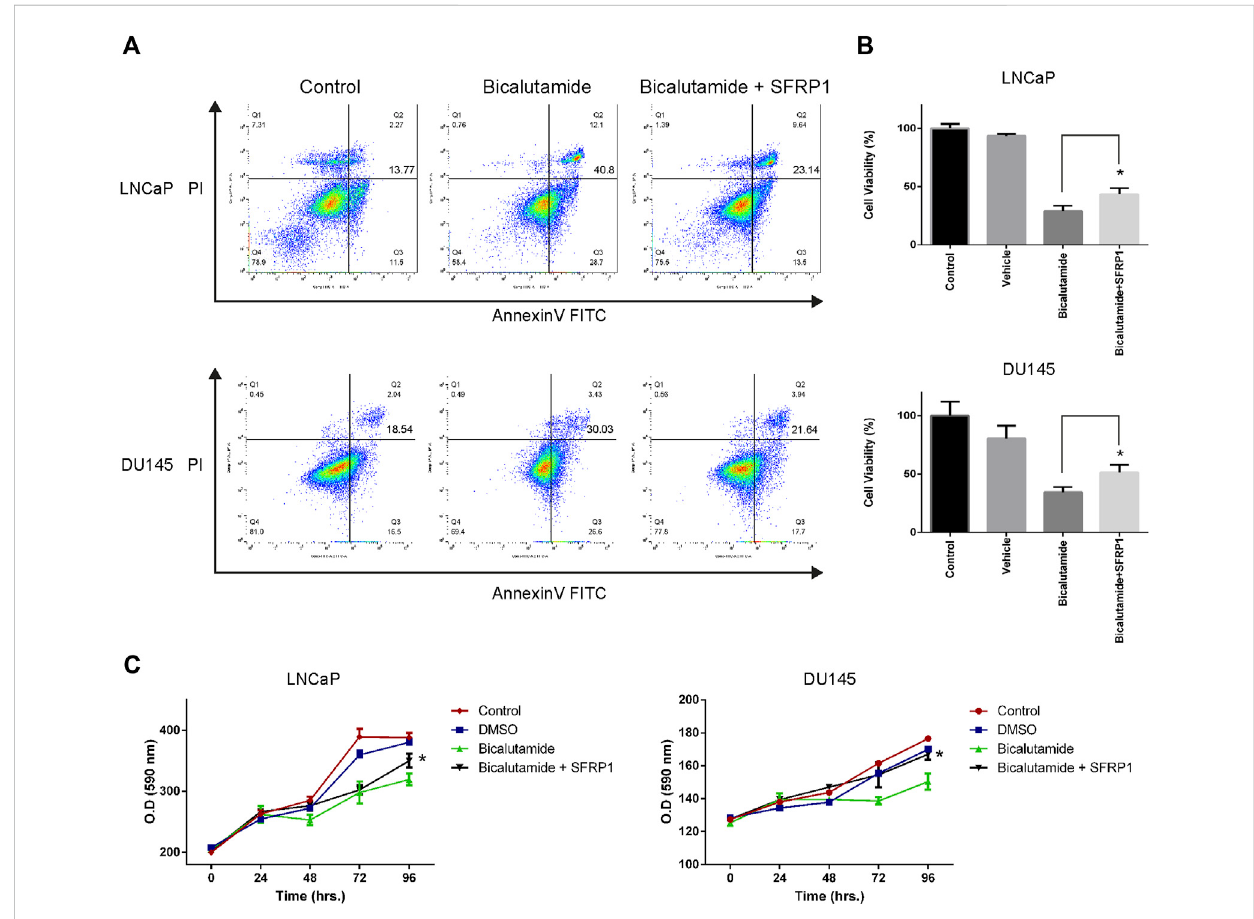
FIGURE 4 (A) Cell apoptosis of LNCaP and DU145 was detected by fl ow cytometry. Cells were treated with either SFRP1 or vehicle (CTRL); FITC-Annexin V coupled antibody and propidium iodide was used for the detection. (B) MTT assay was used to determine cytotoxicity. LNCaP and DU145 cells were treatedfor72 hwithbicalutamide(50 μ M)orbicalutamide+SFRP1orvehicle,(* p < 0.05). (C) ProliferationcurvewasperformusingMTTassaykit.LNCaP andDU145cells weretreatedfor 24, 48,72and 96 hwith:Bicalutamide(50 μ M),bicalutamide+ SFRP1orvehicle,every 24 htheO. D(590